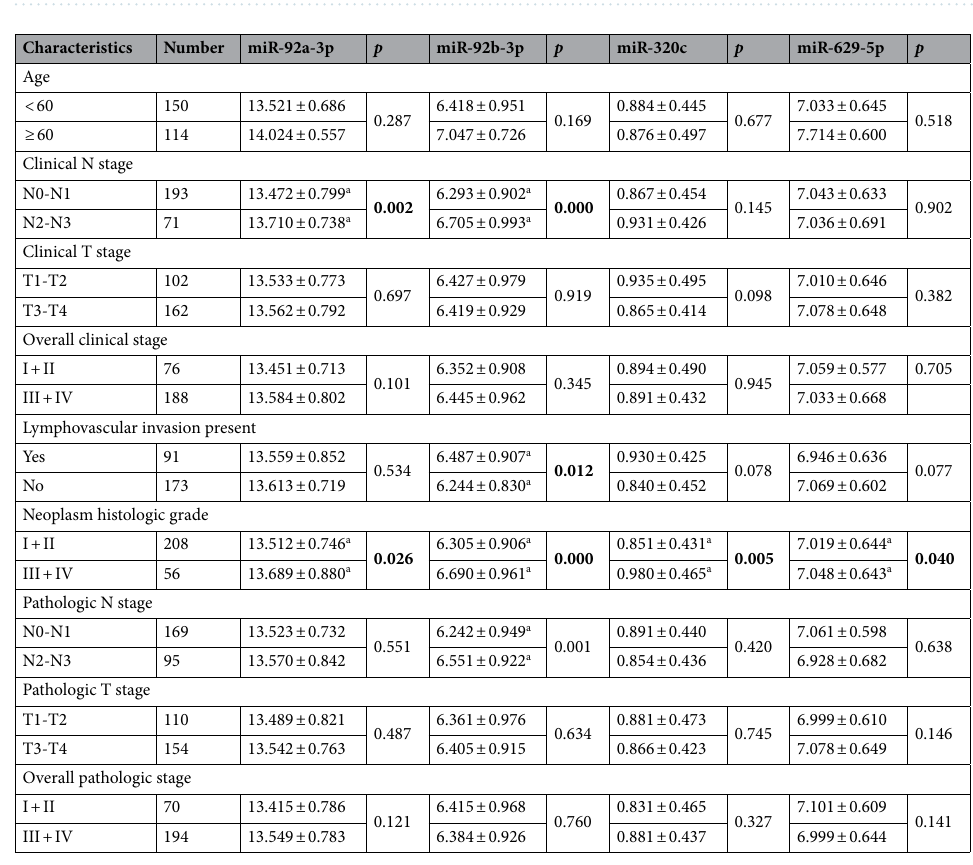
Figure 3. Diagnostic value of the expression of 4 candidate miRNAs. Receiver operating characteristic curve analyses of the specific 4-miRNA panel in ( A ) the Chungnam National University Hospital (CNUH) cohort and ( B ) the The Cancer Genome Atlas (TCGA) cohort.